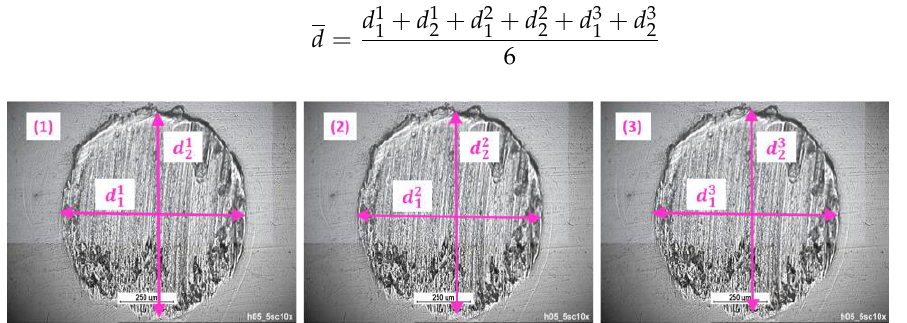
Figure 4. The principle of calculating the average diameter of the wear scar in a given test run: ( 1 ) the wear scar on the first ball, ( 2 ) the wear scar on the second ball, ( 3 ) the wear scar on the third ball.